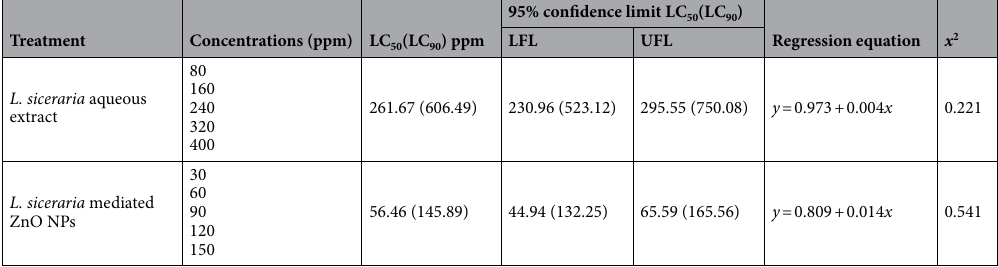
Table 1. Larvicidal activity of L. siceraria extract and its mediated ZnO NPs against III instar Anopheles stephensi larvae (after 24 h exposure).